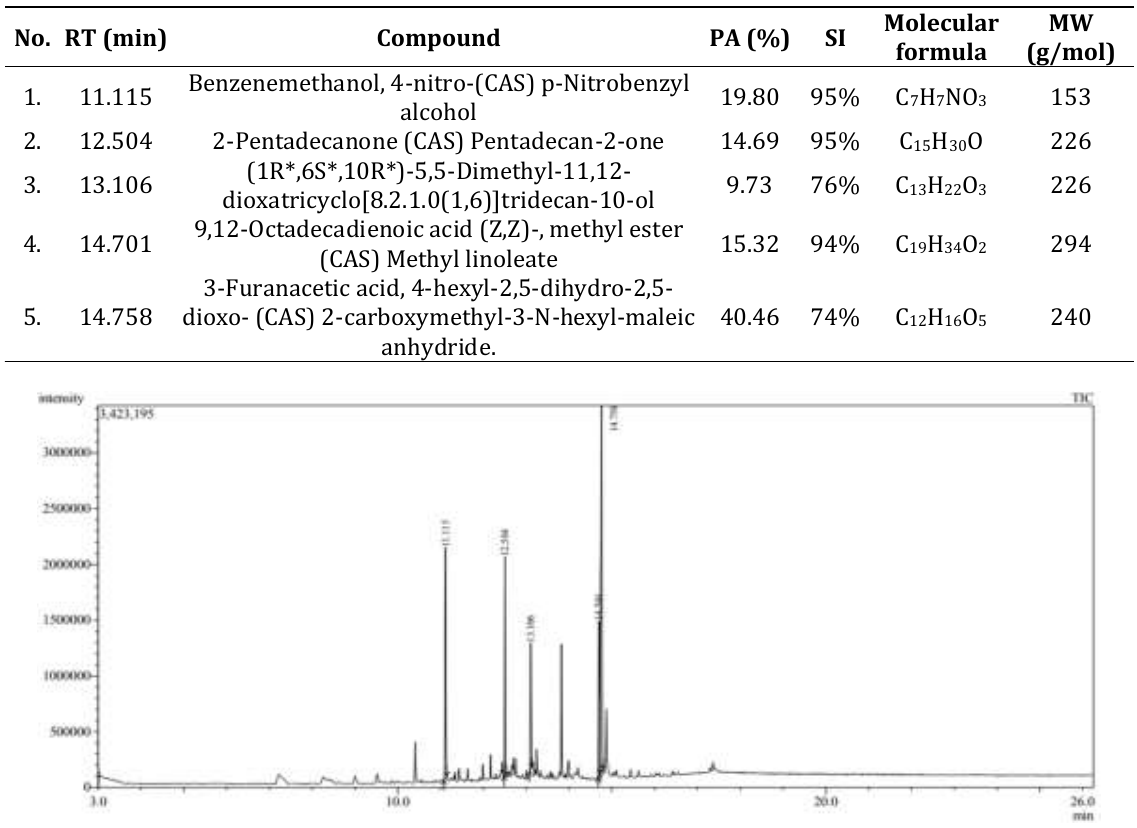
Table II. Phytochemical components in broth medium of ethyl acetate extract of E. linearis